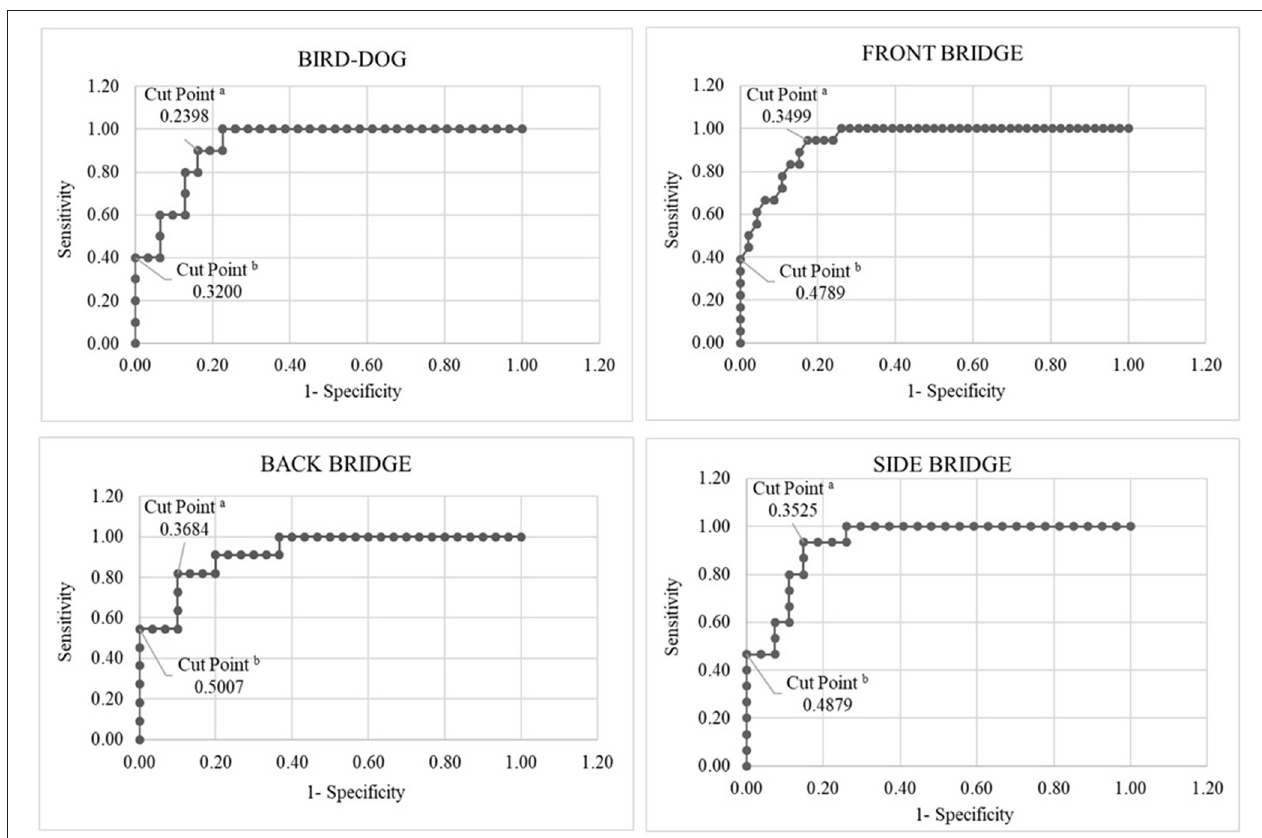
FIGURE 3 | Receiver operating characteristic curves linking the expert ratings with the pelvic accelerations obtained in each of the core stability exercises. a Cut point using Youden Index; b Cut point minimizing